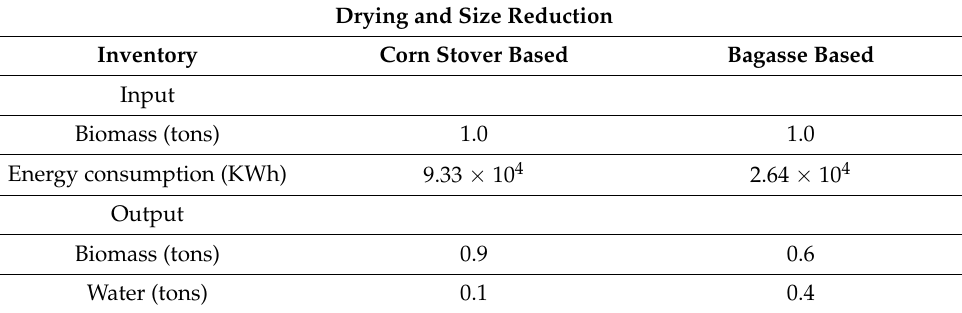
Table 1. Material and energy inputs and outputs in drying and size reduction in raw corn stover and